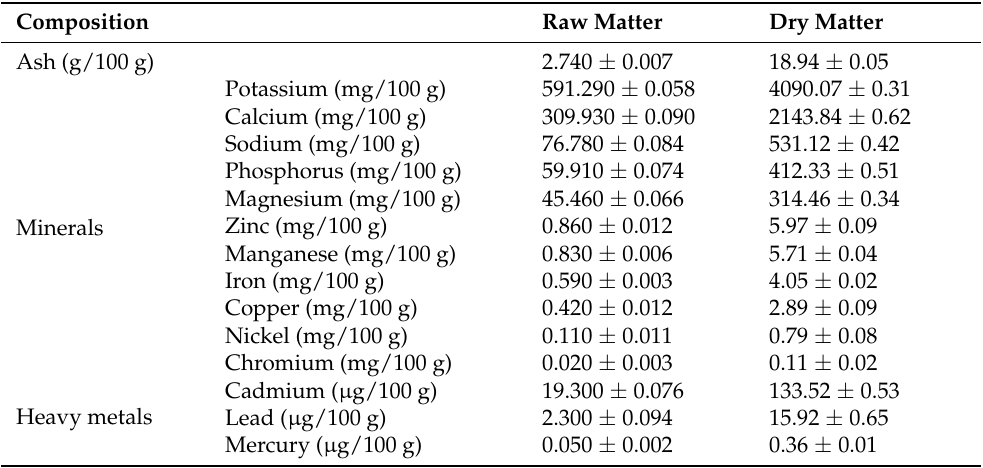
Table 3. Minerals and heavy metal composition of Crepis vesicaria subsp. taraxacifolia leaves (mean ± SD; n = 3).